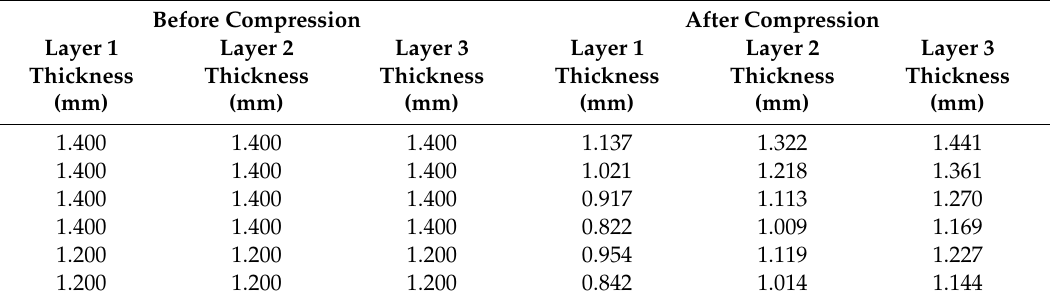
Table 3. Thickness of each layer for the three-layer compression (this work).